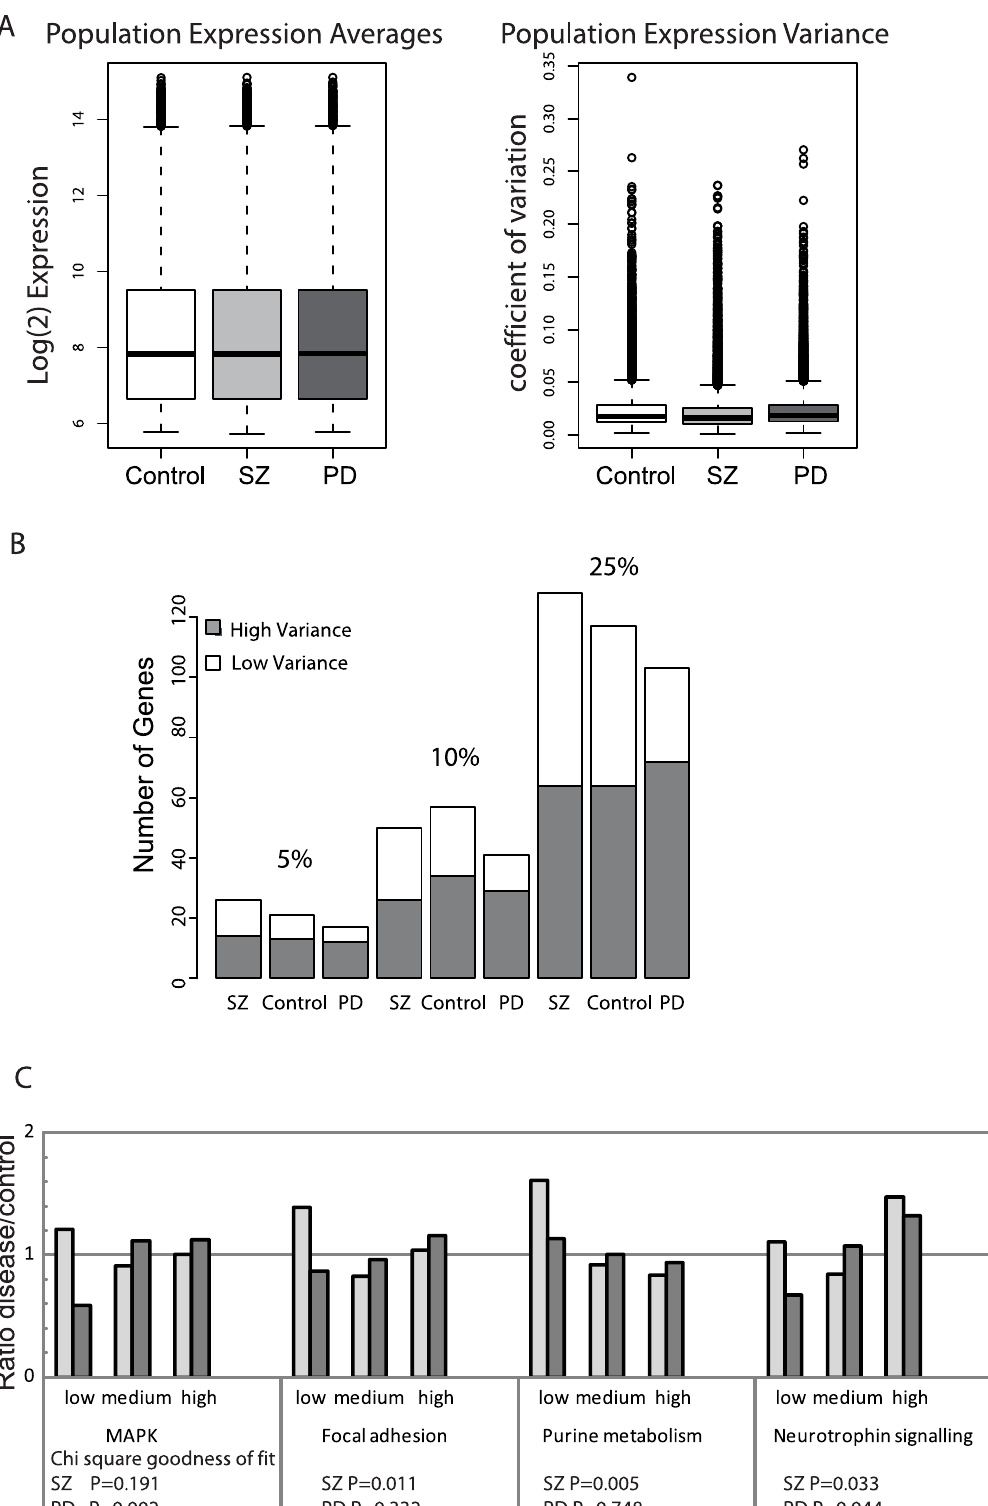
PLoS Genetics | www.plosgenetics.org 7 August 2011 | Volume 7 | Issue 8 |